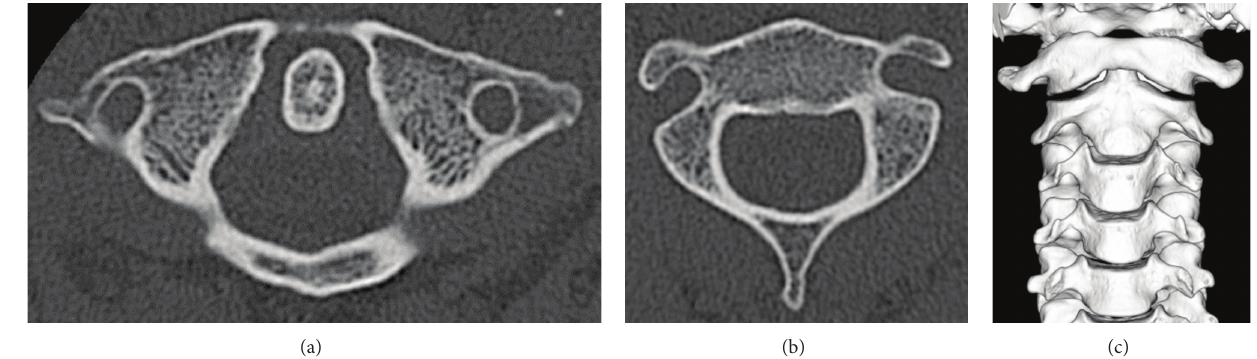
Figure 4: CT after reduction of atlantoaxial rotatory fixation. (a) Axial view of atlas, (b) axial view of axis, and (c) anterior view of three- dimensional CT. Table 1: Reported cases with adult atlantoaxial rotatory fixation in the